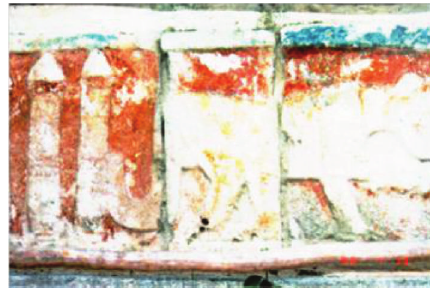
Figure 1: A photograph of a monument in Chichen Itza, YUC (900 C.E.), Mexico, painted with Maya Blue, from [6].